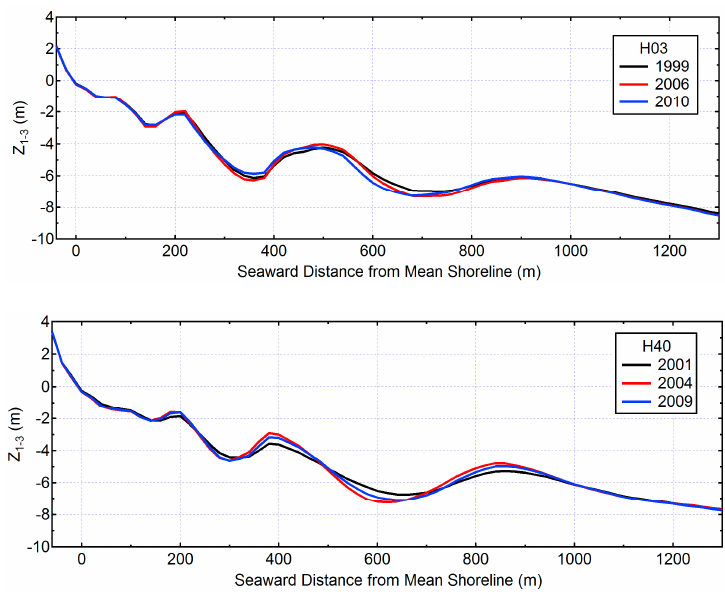
Figure 20. Examples of cross ‐ shore profiles when net offshore migration (NOM) ‐ related modes indicate shoreline retreat.